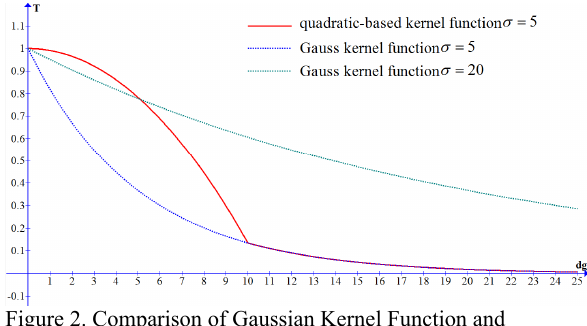
Figure 2. Comparison of Gaussian Kernel Function and Quadratic-based Kernel Function In Figure 2, the horizontal axis represents the absolute value of intensity difference  g ; and the vertical axis represents the value of constraint term T . ( )  T is defined as the value of T q computed by the quadratic-based kernel function. ( )  T is G